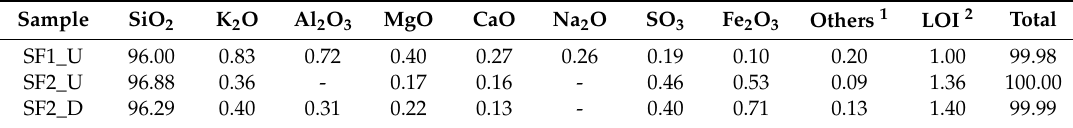
Table 1. Chemical composition of silica fume